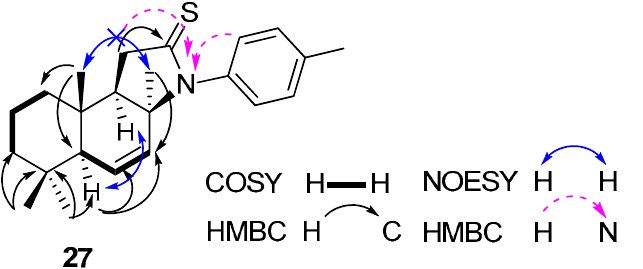
Figure 3. Selected COSY, HMBC, NOESY, and HMBC correlations for compound 27 . However, in the case of amide 28 , from the thionation reaction mixture, the same amides 26 and 27 were isolated in 37% and 21% yields, respectively (Scheme 4). Their spectral data were in accordance with those obtained